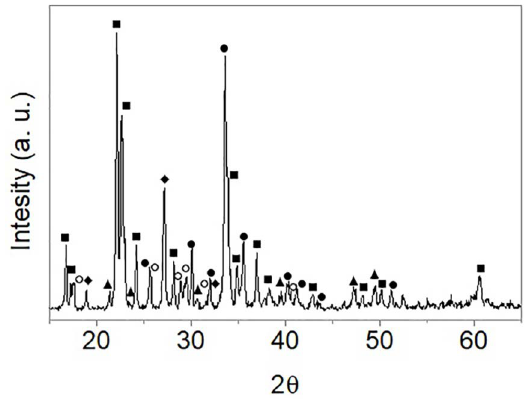
SiO . Crystalline phases Li 4 4